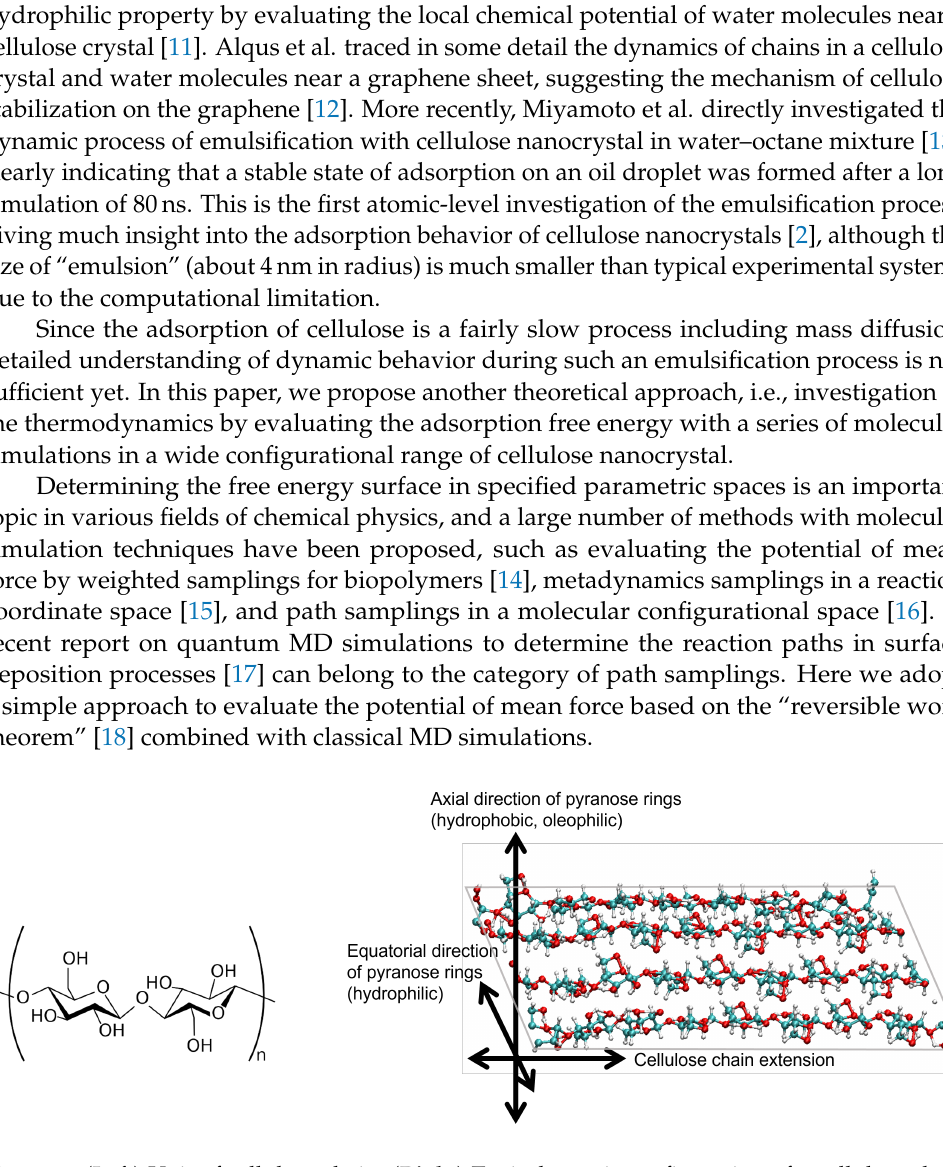
Figure 1. ( Left ) Unit of cellulose chain; ( Right ) Typical atomic configuration of a cellulose sheet showing characteristic directions. Cyan: carbon atoms, red: oxygen, white: